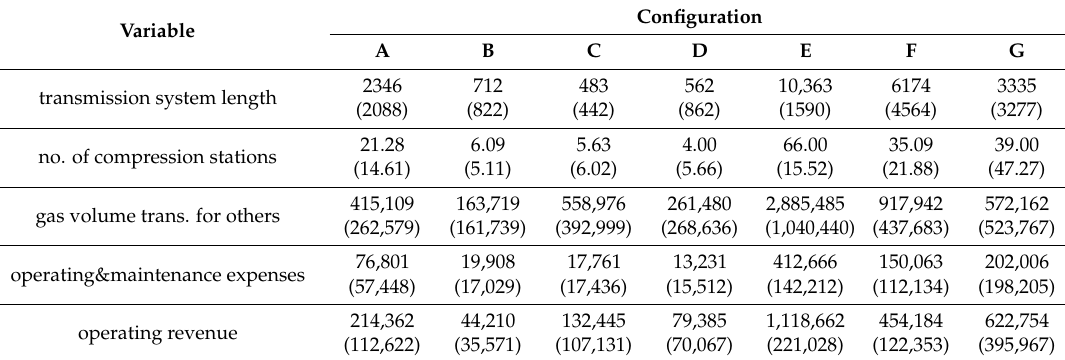
Legend: Table contains mean and standard deviation measurements relative to each configuration. Standard deviation values are in